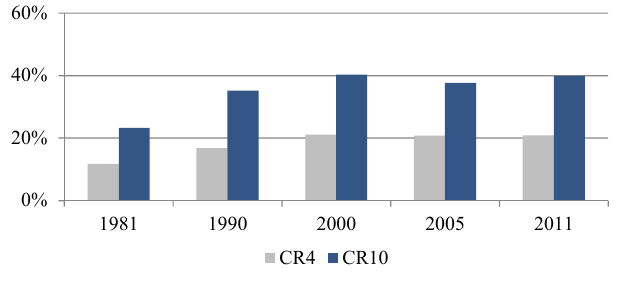
Fig. 3 - Level of concentration in the global pharmaceutical market between 1981 to 2011. Source: PharmTech (2012), Deutsche Bank (2012), Contract Pharma